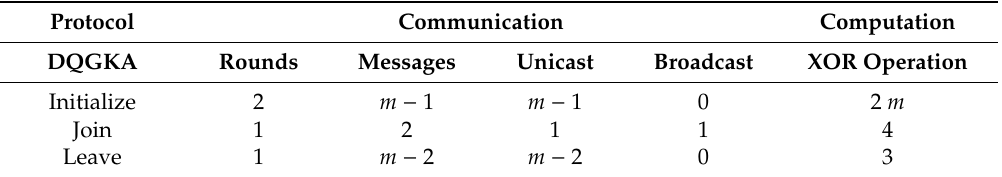
Table 2. DQGKA computation and communication